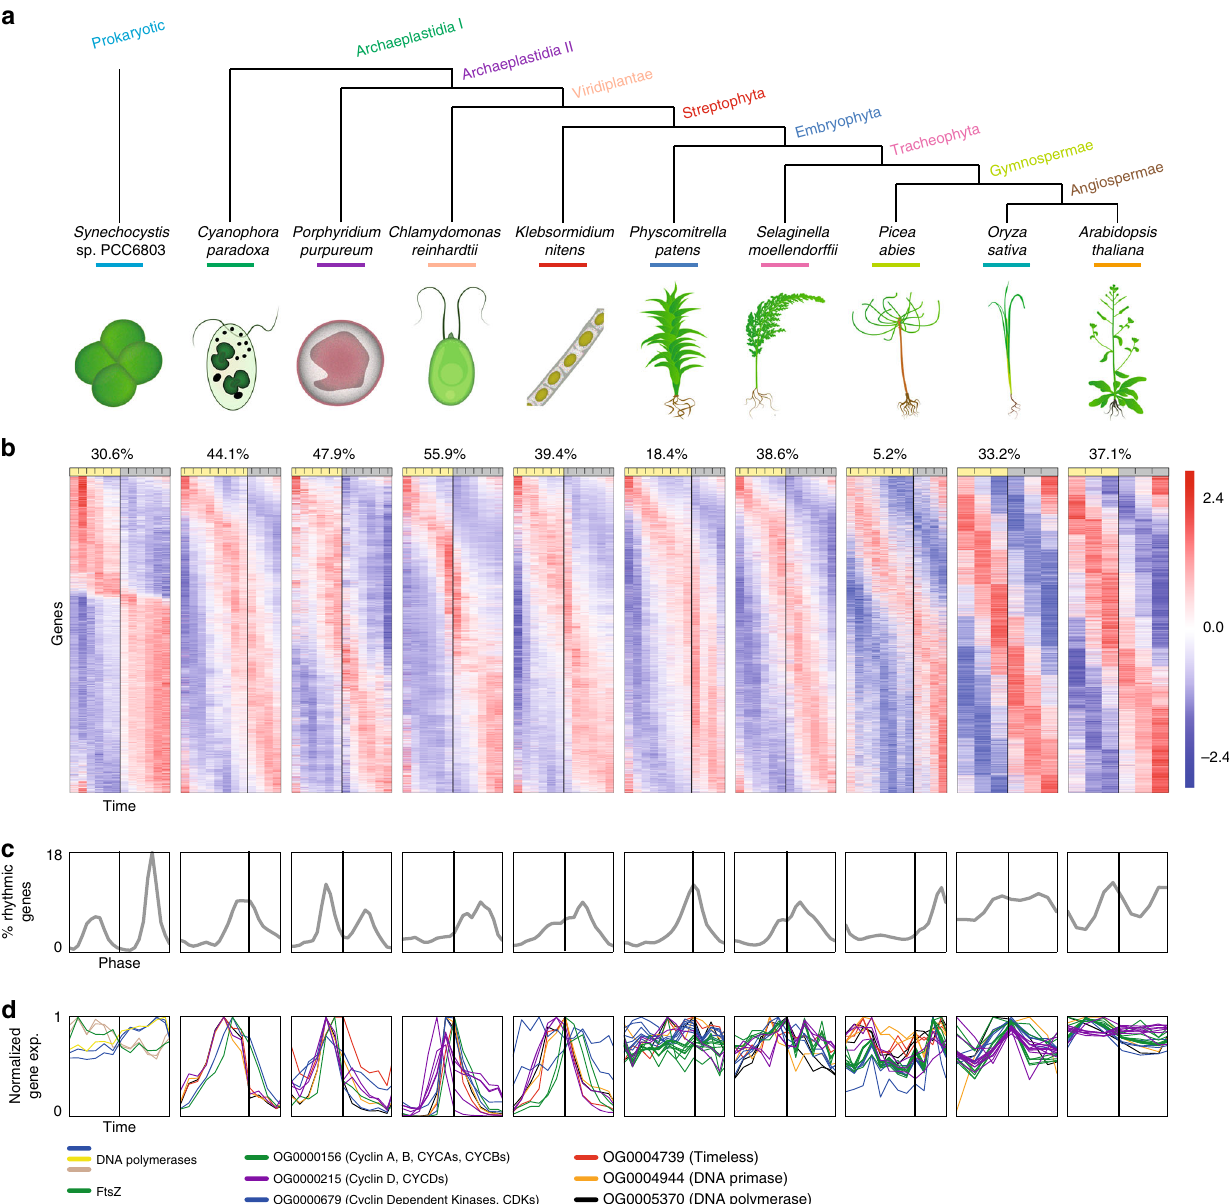
Fig. 1 Diurnal gene expression of plant clades. a Species tree of the Archaeplastida, together with the respective phylostratum of each clade. Synechocystis sp. PCC 6803 is included as a cyanobacterial outgroup. b The percentage of rhythmic genes in a given species is shown above the yellow (light) and gray (darkness) bar indicating the photoperiod of each diurnal experiment. Below, z -score-standardized gene-expression pro fi les for each species sorted by the phase, signifying the time point of highest expression during the day. c Phase distribution of rhythmic genes through the diurnal experiment. d Expression pro fi les of cell division genes. The coloured lines indicate the different gene families. Each family can have more than one